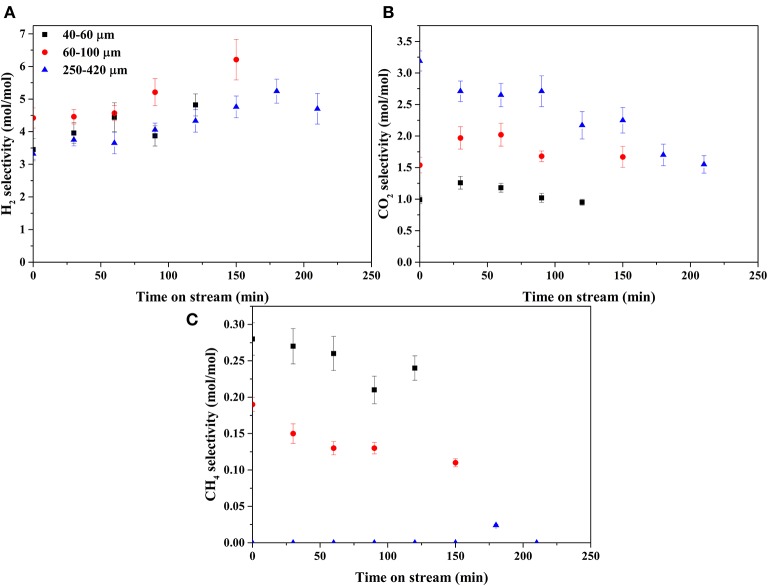
Selectivities of gaseous products: (A) H2, (B) CO2, and (C) CH4.